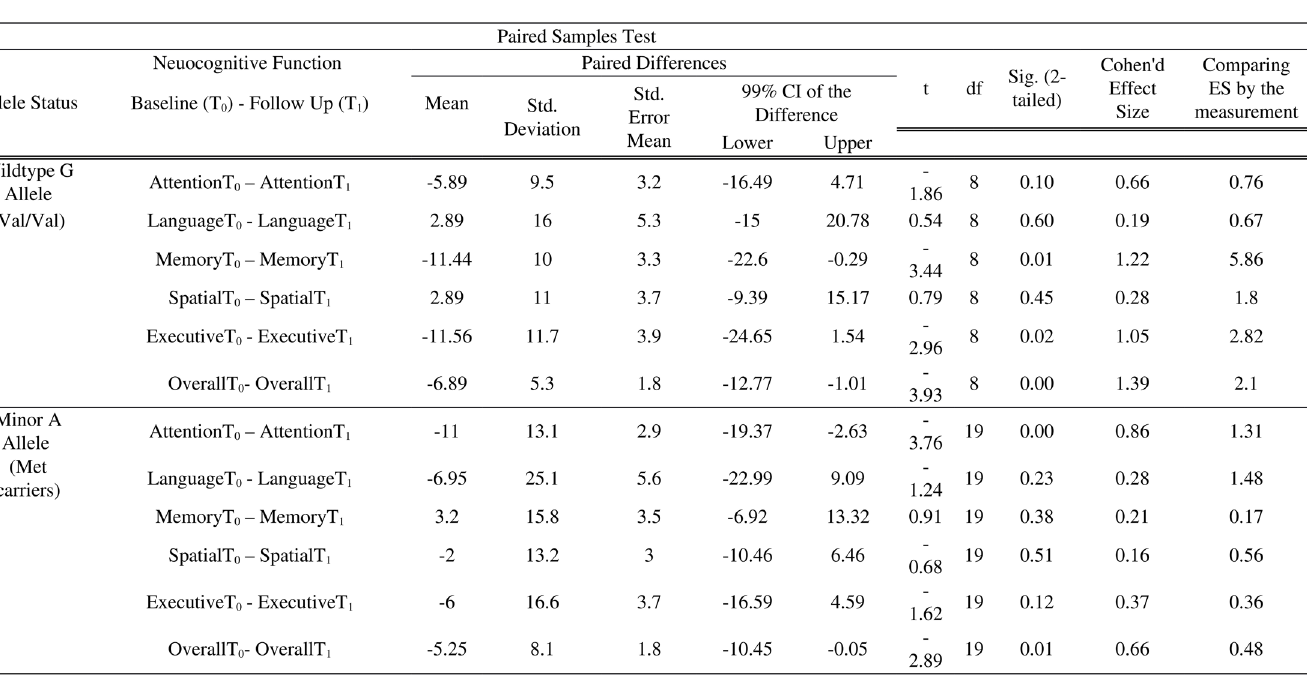
Fig 5. Paired-sample t-test, Cohen ’ s d effect size (ES) calculation, and the comparison of ES by the measurement of the domain specific standard scores (SS) across the time points (admission vs. 6 month follow up) based on the BDNF rs6265 allele status.